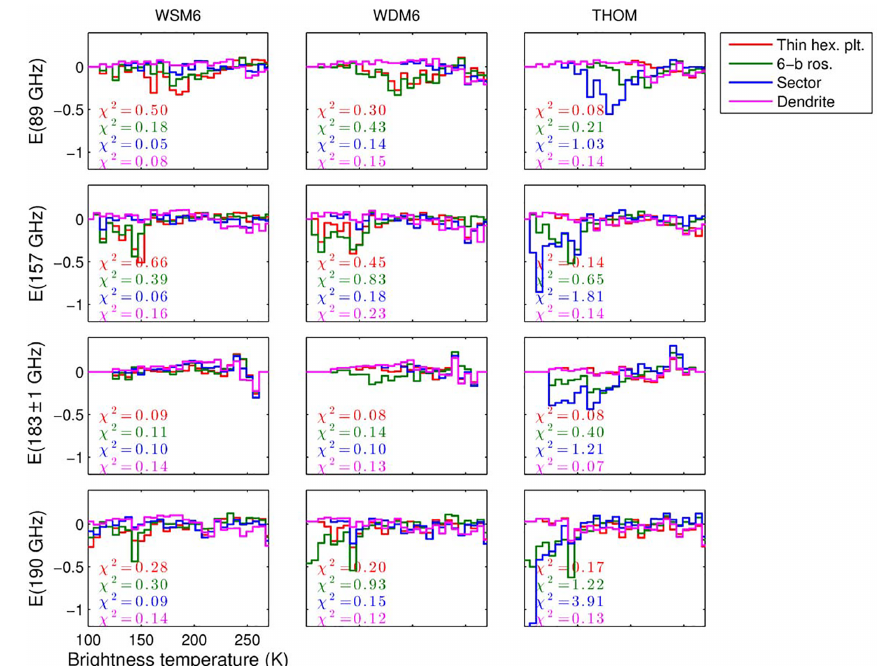
Figure 13. The simulated (solid coloured lines) residuals of the χ 2 test for the MHS brightness temperature distributions. Note that the χ 2 value is included for each of the DDA habit simulated distributions calculated from all temperature bins below 270K (250K for the 183 ± 1GHz